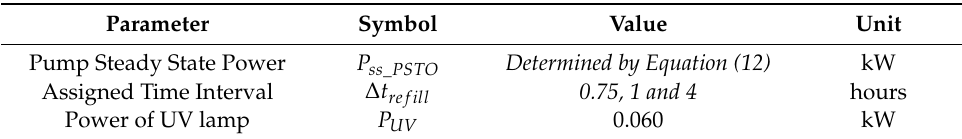
Table 8. Parameters for Equation (14) specifying parameter, symbol used, value and units used. Parameter Symbol Value Unit Pump Steady State Power P ss _ PSTO Determined by Equation (12) kW Assigned Time Interval ∆ t refill 0.75, 1 and 4 hours Power of UV lamp P UV 0.060 kW